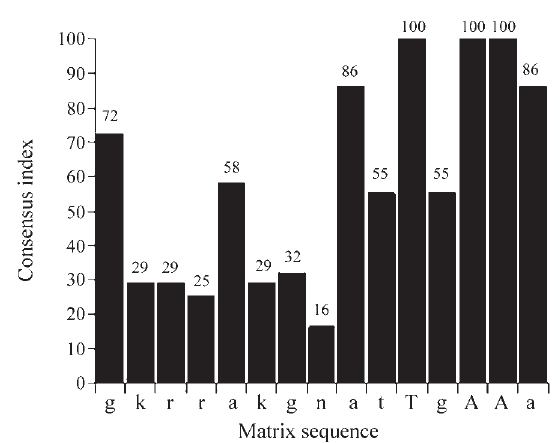
Figure 1 - Matrix sequence output by MatDefine from GEMS Launcher suitev3.6usingdamagerepairelements(DRE)identifiedfromyeastDNA repair genes. Capital letters in the DNA sequence represent nucleotide po- sitions with high consensus index score (Ci-value > 60) as indicated by MatInspector. Ci-values are shown above the gray bars.